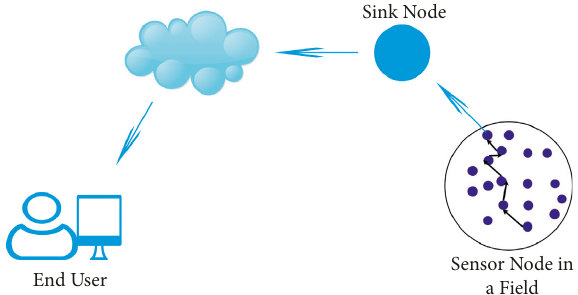
Figure 1: Wireless sensor network architecture.